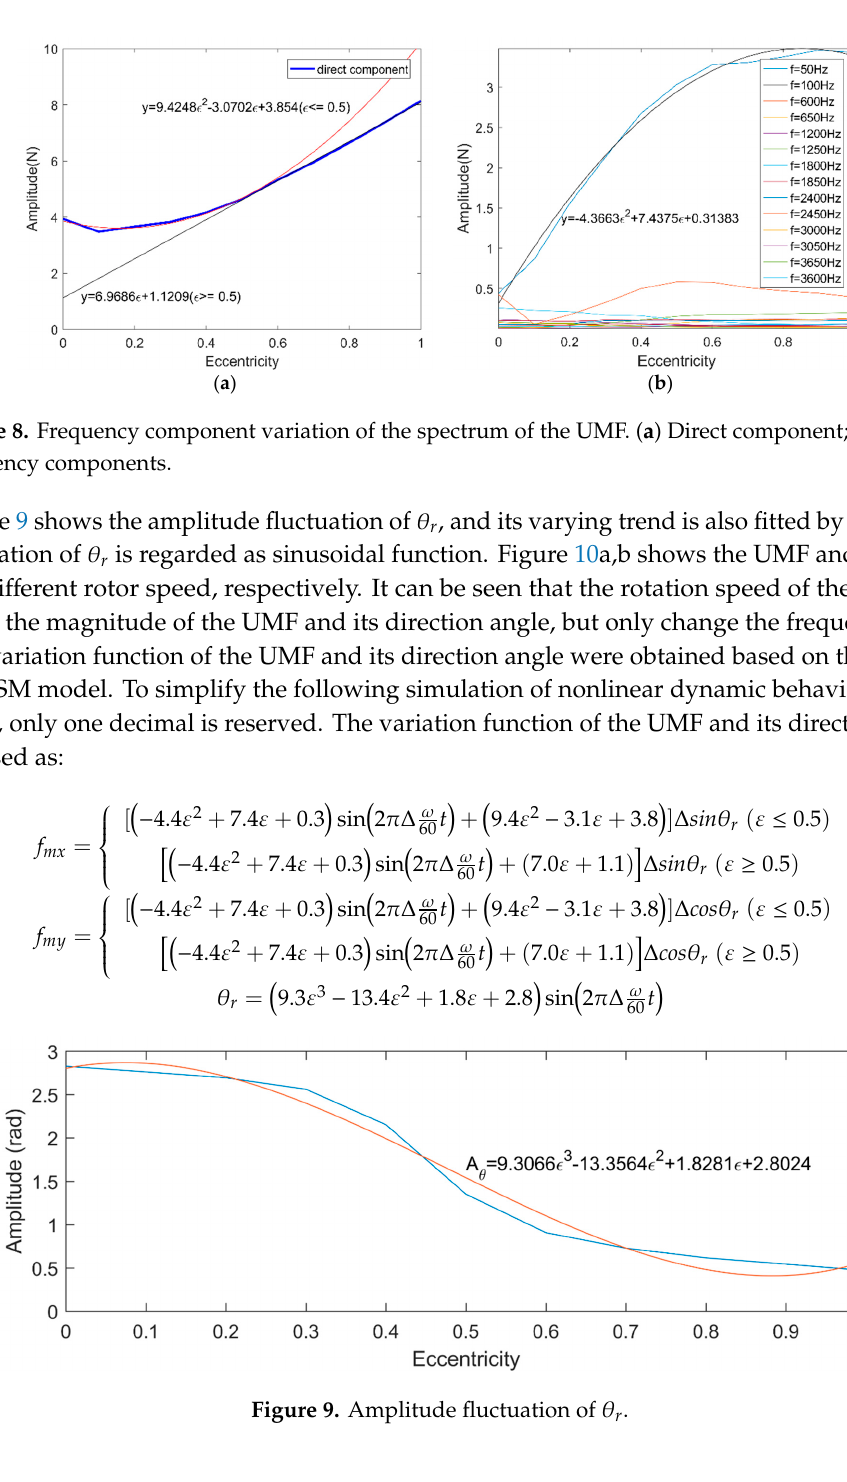
Figure 7. Frequency spectrum of the UMF. ( a ) 0% eccentricity; ( b ) 100% eccentricity.